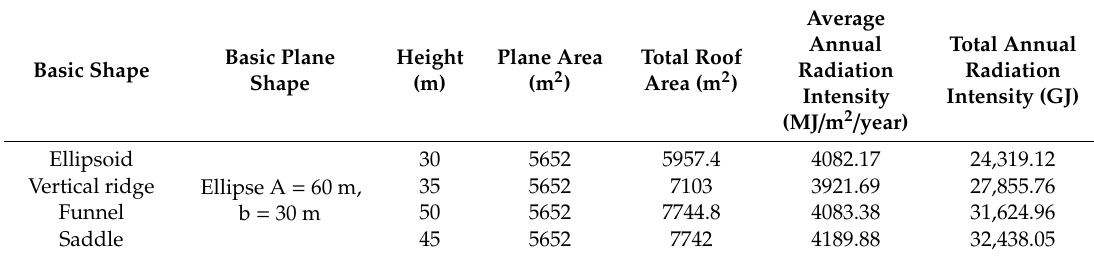
Table 4. Structural parameters of the elliptical building and annual radiation intensity of its roof.